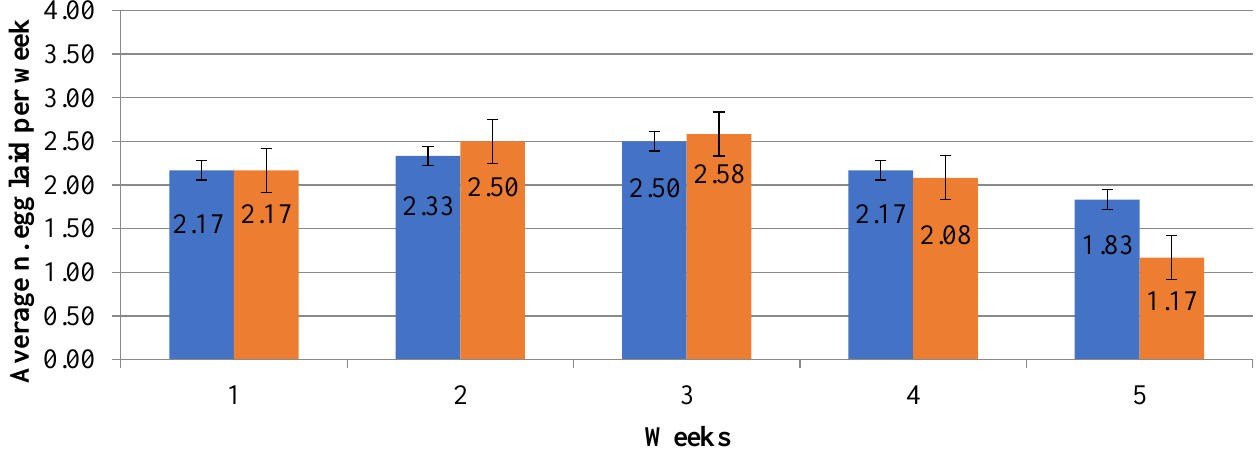
Figure 1. Histogram of laying efficiency in partridges of the two experimental groups (CON vs. TM5%) across the experimental period (5 weeks) Blue bars for CON and orange bars for TM5%. Average number of laid eggs is reported from 24 couples (CON = 12 vs. TM5% = 12).